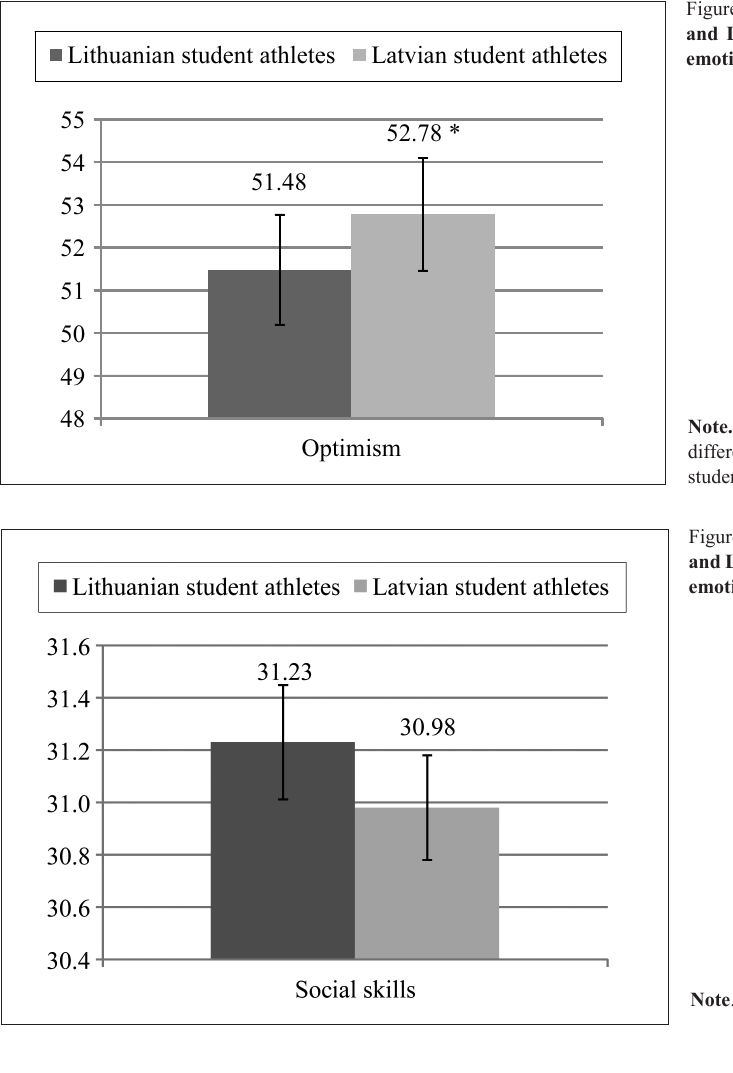
Figure 1. Mean scores of the ability of the Lithuanian and Latvian student athletes to use personal positive emotional experience (optimism)